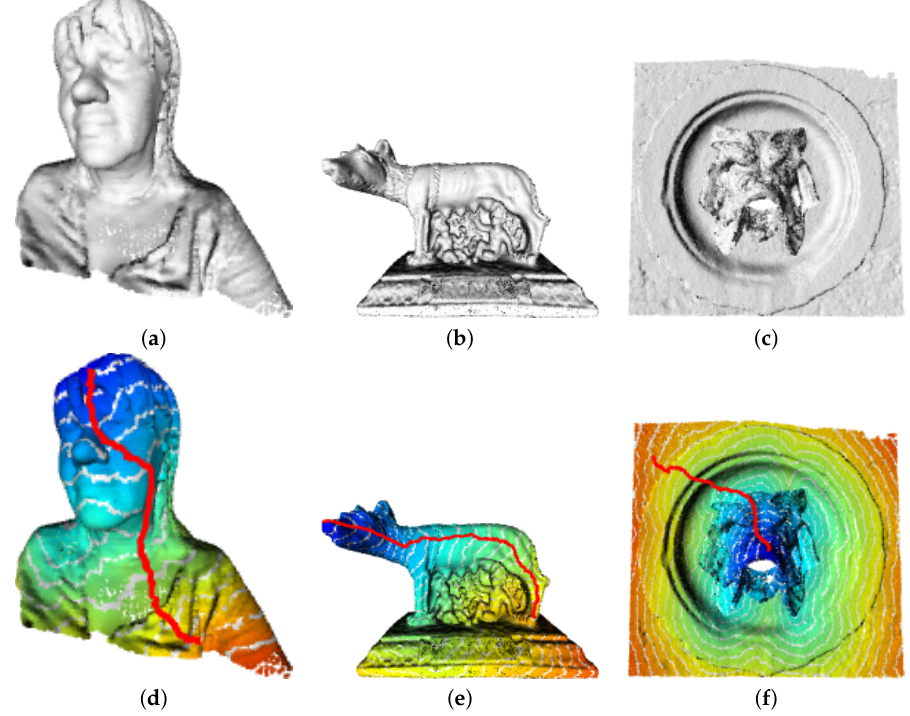
Figure 7. Geodesic distances on 3D point clouds with the Eikonal equation on the graph. ( a – c ) show the original point clouds; ( d – f ) show the evolution of the distances with the minimal path linking two points of the point cloud. Blue and red color show low and high distances, respectively. White lines display isolines.